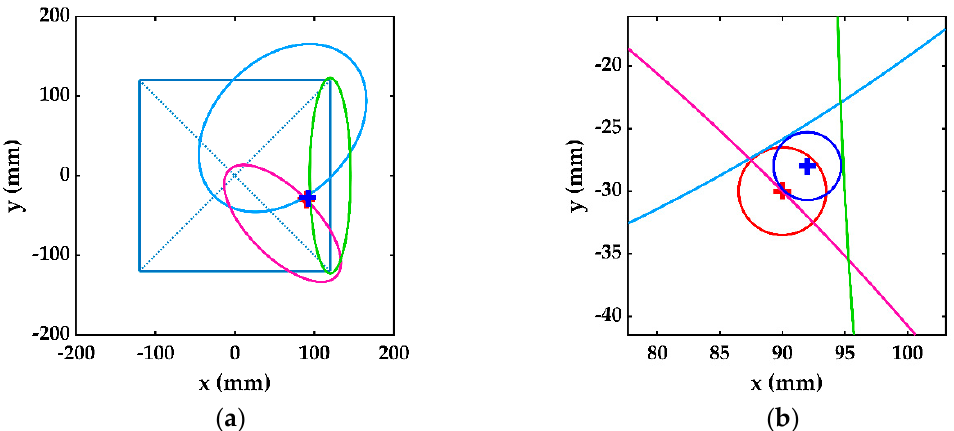
Figure 12. ( a ) Ellipses formed in the second-stage damage detection method. ( b ) Estimated (blue) and actual (red) damage.